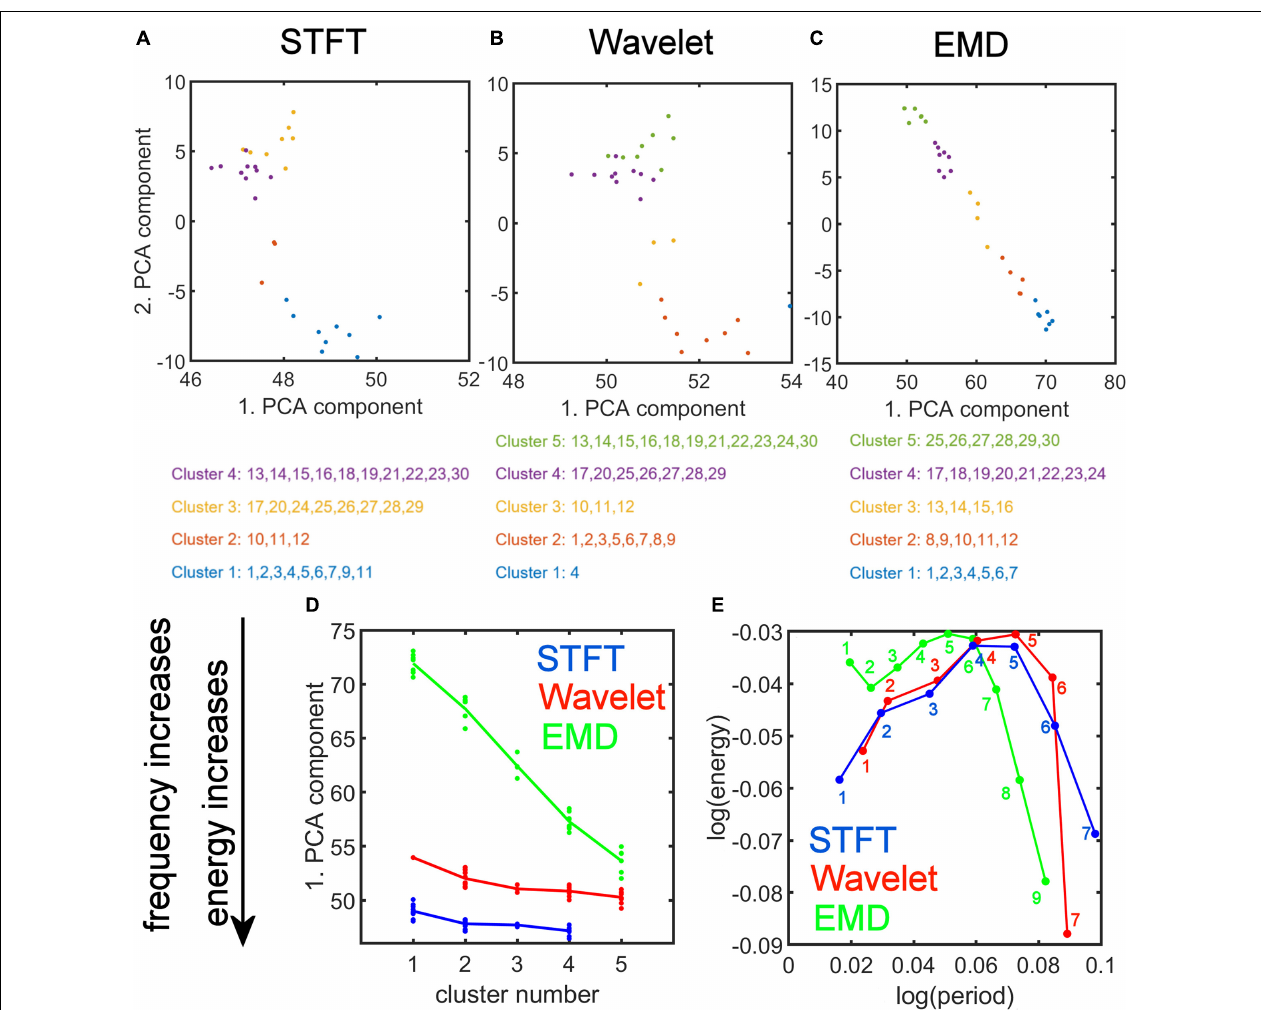
FIGURE 9 | Strong Relationship of EMD to Principal Component Analysis (PCA). Top : (A,B,C) PCA of the feature data matrix obtained by the Short-Time Fourier Transform (STFT), the Maximal Overlap Discrete Wavelet Transform (MODWT), and Empirical Mode Decomposition (EMD). The scatter plots show the first and second PCA component values for 30 resting-state networks that were classified into four clusters by STFT (A) , five clusters by the MODWT (B) , and five clusters by EMD (C) . Networks belonging to the same cluster have the same color. Bottom : (D) Relationship of the value of first PCA component to frequency and energy content (see downward pointing arrow) of the clusters using different methods (STFT, MODWT, and EMD). (E) Feature values for log ( period ) and log ( energy ) corresponding to the first eigenvector for each decomposition level (IMFs 1–9 for EMD, 1–7 for STFT and MODWT), averaged over all subjects. Note that the contribution to the energy is largest for IMFs 1–6 of the EMD method among the three methods. Summary: Note that the clusters determined by EMD (C) show a strong (almost linear) relationship in the 2-dim PCA plot, which is not the case for STFT (A) and Wavelet (B) . Also note that EMD has a strong frequency and energy relationship to PCA (D) . As shown in panel (D) , EMD provides the largest separation in frequency and energy content of the clusters of ICA networks compared to STFT and Wavelet methods. In fact, clusters identified by EMD are characterized by increasing frequency and energy content with increasing cluster number (i.e., the higher the cluster number, the higher will be its frequency content), whereas the corresponding figures for STFT and Wavelet are rather flat and uninformative of the frequency content.